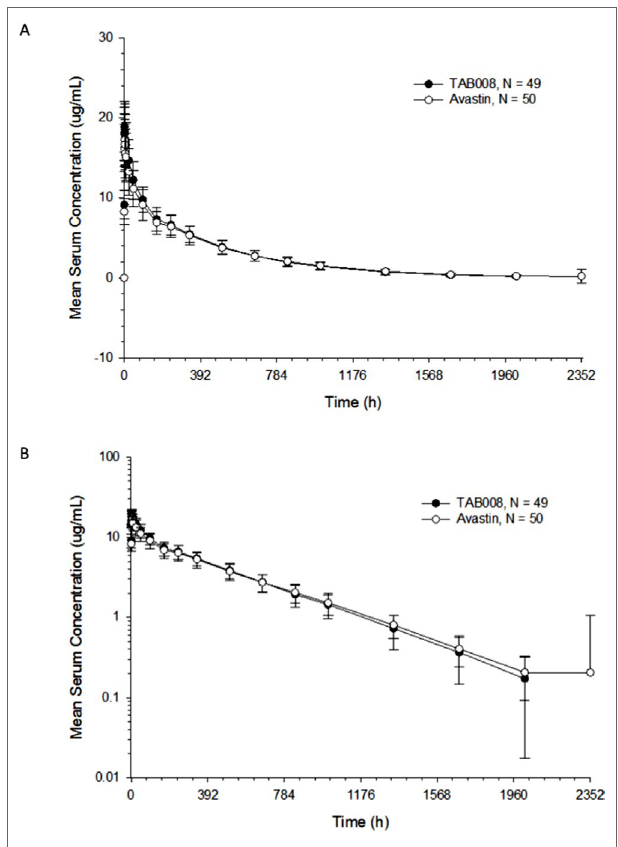
FIGURE 2 | Arithmetic mean (± SD) bevacizumab serum concentration–time profiles for TAB008 versus Avastin ® on linear (A) and semilogarithmic scales (B) .